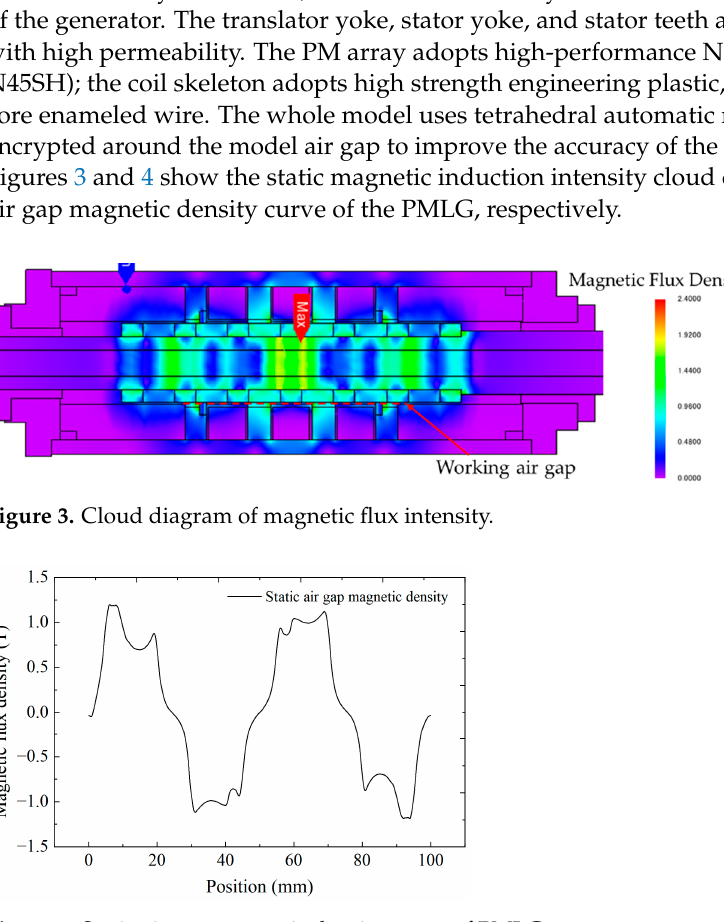
Figure 4. Static air gap magnetic density curve of PMLG.